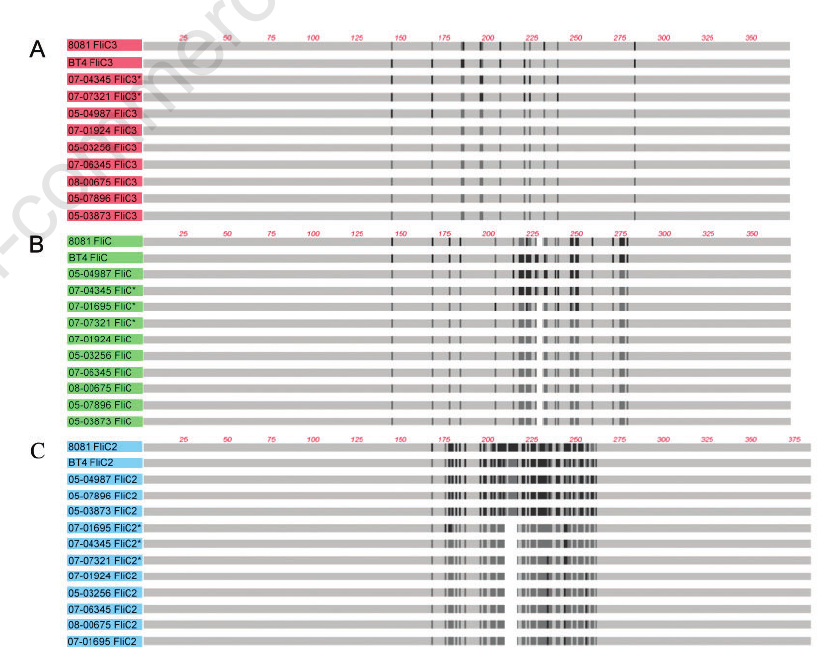
Figure 3. Protein alignment of the three flagellins from 10 different Y. enterocolitica bio- type 1A strains compared to flagellins from Y. enterocolitica biotype 1B strain 8081 (“8081”) and Y. enterocolitica biotype 4 strain 07-07073 (“BT4”), the latter being repre- sentative of ten biotype 4 strains sequenced (see Table 1). Colour code of genes is as intro- duced in Figure 1 and Table 1. Identities among all isolates in light grey, identity to the consensus sequence in dark grey and deviation from the consensus sequence in black. Asterisks indicate relocated flagellin genes compared to the order of flagellin genes found in Y. enterocolitica 8081 (Figure